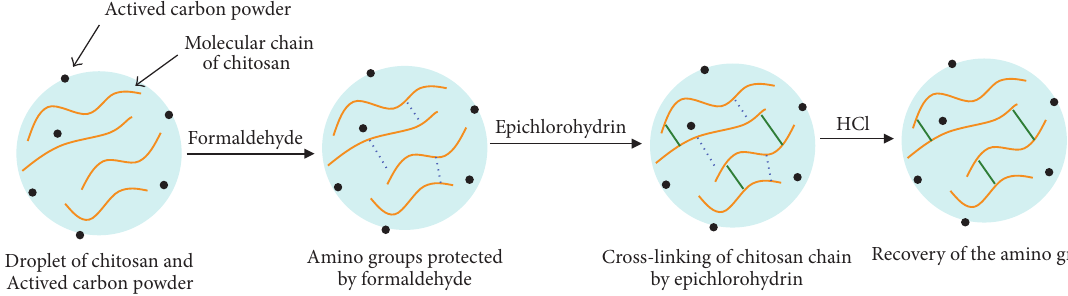
was reacted with NH 2 groups of chitosan to form Schiff